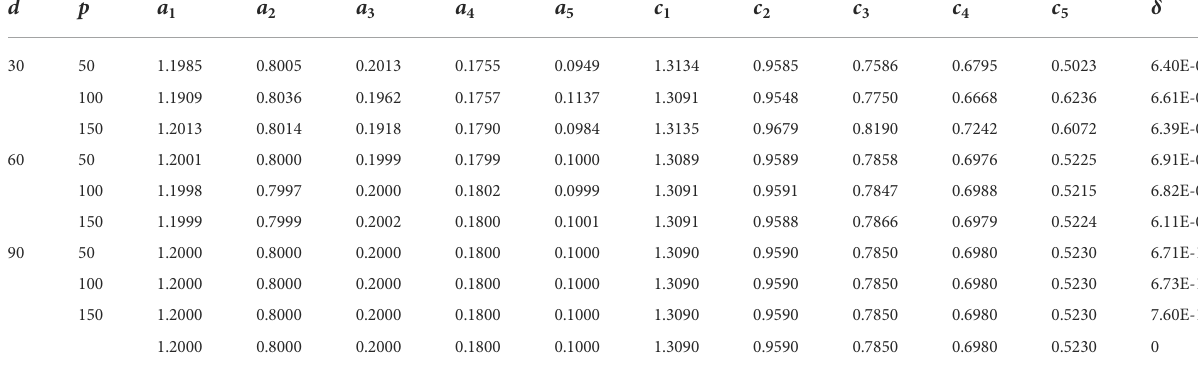
TABLE 7 Results of parameter estimates of Example 2 for G = 1,500.